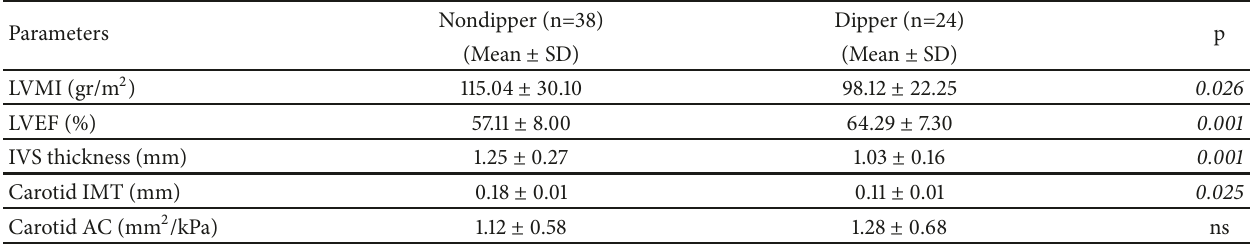
Table 4: Results of echocardiography and carotid Doppler ultrasound in